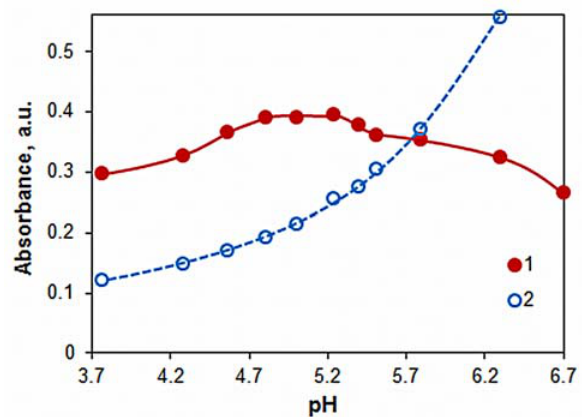
= 2 × 10 –5 mol dm –3 , c V(V)